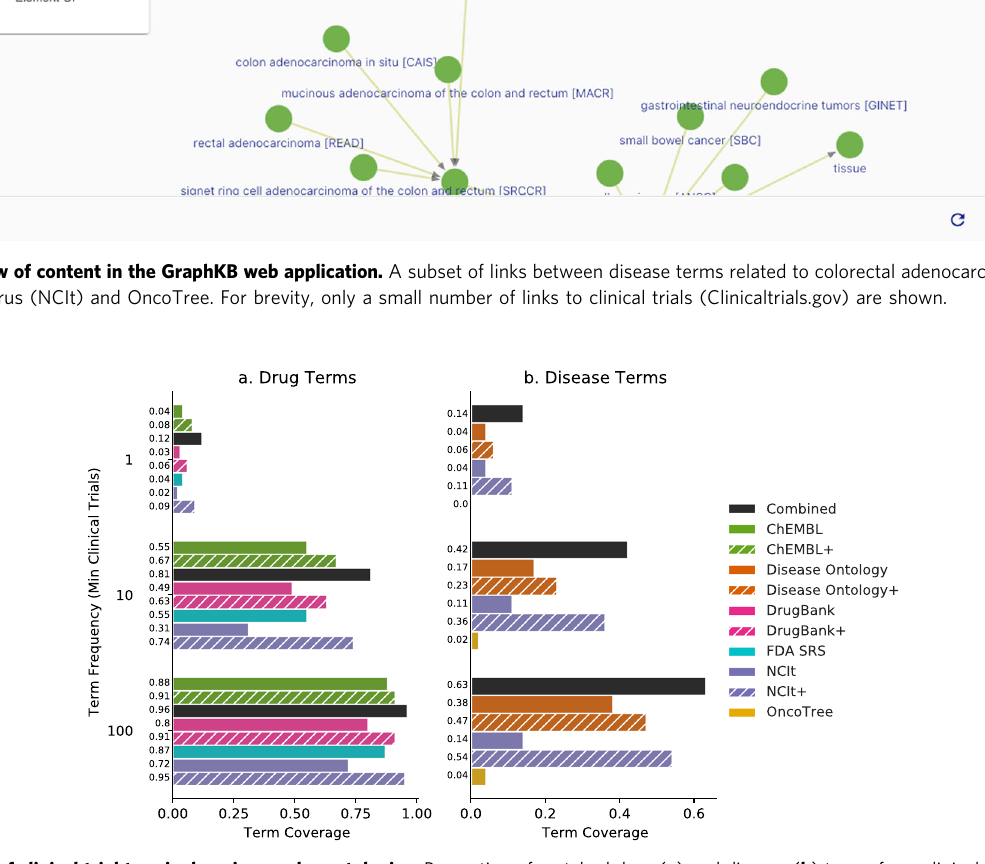
Fig. 6 Coverage of clinical trial terminology in popular ontologies. Proportion of matched drug ( a ) and disease ( b ) terms from clinical trials matched by ontology terms across multiple resources. A distinction was made between the primary/preferred terms for a given resource and the set of all terms (indicated with a + ), which included synonyms, aliases, and commercial product names. The proportion of total clinical trials terms where an exact match was found in a given ontology is termed coverage. Coverage was calculated for trial terms at 3 frequencies (1 + , 10 + , or 100 + ) where the frequency is calculated as the number of clinical trials a given term was used in. Source data are provided as a Source Data fi